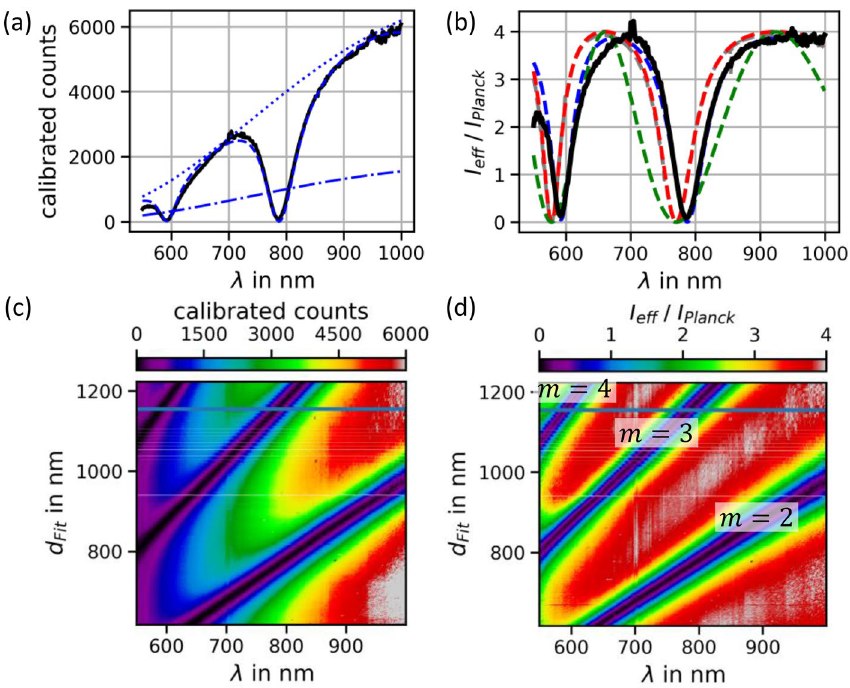
Figure 2. The left column shows calibrated experimental spectra, the right column shows modification factors to Planck part according to Eq. (1). The blue dashed line in ( a ) corresponds to the complete TMM fit model, the dash-dotted line is I Planck . The dotted line is 4 · I Planck which also serves as envelope. The deep imprints originate from destructive interference, the fourfold enhancement of intensity stems from constructive 2-path interference. The dashed lines in ( b ) showcase the contributions from the dielectric and material specifics of the mirror, see main text. ( c ) Shows the full body of calibrated experimental spectra. ( d ) Displays the modification factor of all data according to Eq.